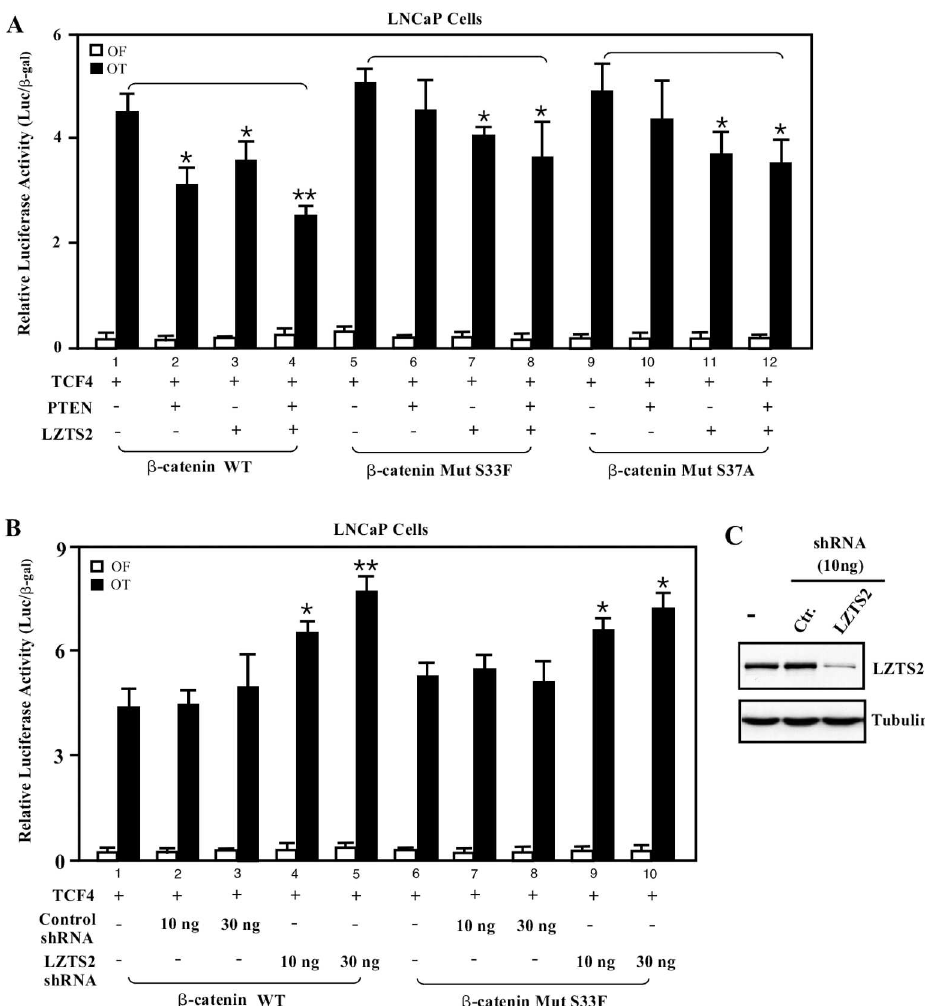
Fig 2. LZTS2 and PTEN collaboratively repress β -catenin-mediated transcription. (A) One hundred ng of pGL3-OT (OT) or pGL3-OF (OF), 25 ng of pcDNA3-ß-gal, 5 ng of TCF4 expressionvector, and 50 ng of wild-typeor mutant ß-catenin were co-transfected with either pcDNA3-FLAG-hLZTS2 or pCMV5-PTEN plasmidsalone or togetherinto LNCaP cells. Cell lysates were measuredfor luciferase and ß-gal activities. (B) LNCaP cells were transfected with either 100 ng of pGL3-OT (OT) or pGL3-OF (OF), 25 ng of pcDNA3-ß- gal, 50 ng of wild-type or mutant ß-catenin, and control or Lzts2-targeted shRNA as indicated. Luciferaseand ß-gal activitieswere measuredas describedabove. The data represent the mean ± S.D. of three independent samples. (C) LNCaP cells were transfected with either control or LZTS2 targeted shRNAa representative western blot with antibodiesagainst humanLZTS2 or Tubulin is shown. “ * ” or “ ** ” means P < 0.05or < 0.01, respectively.